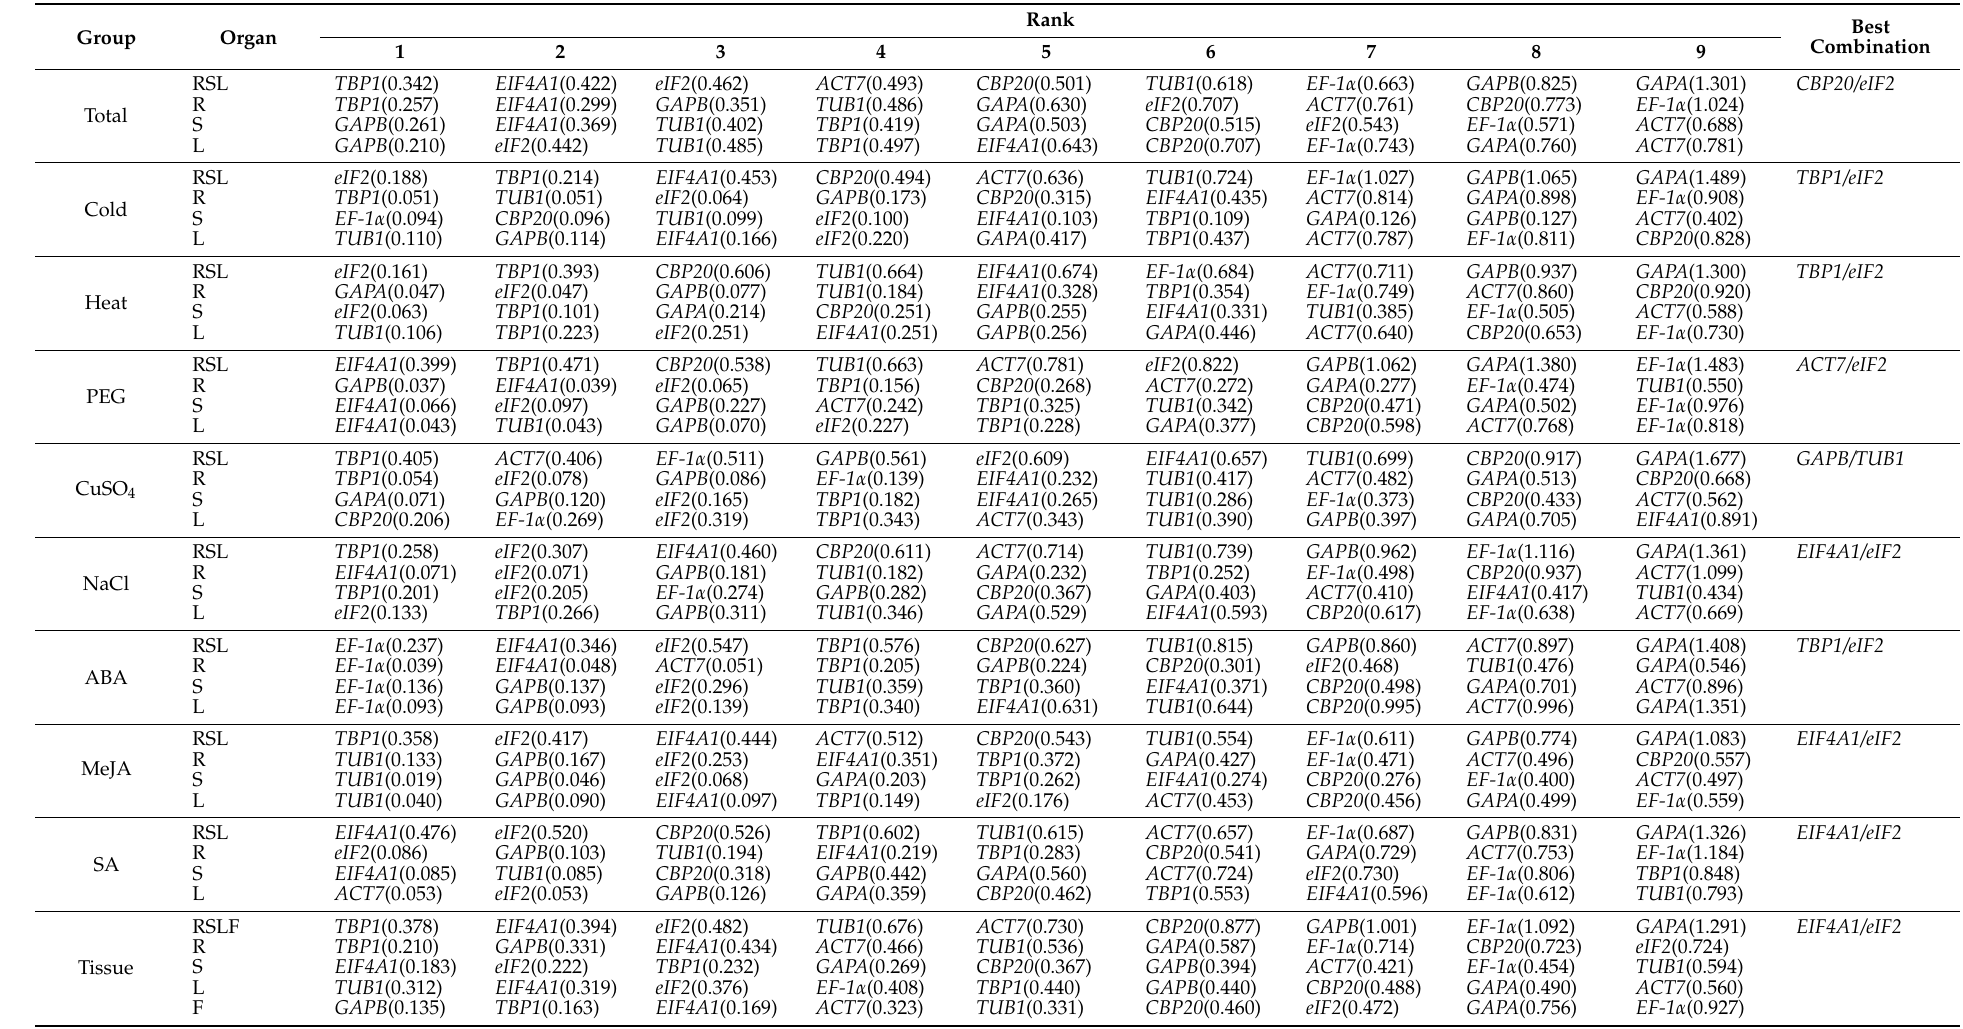
Table 1. Expression stability values for nine candidate reference genes calculated by